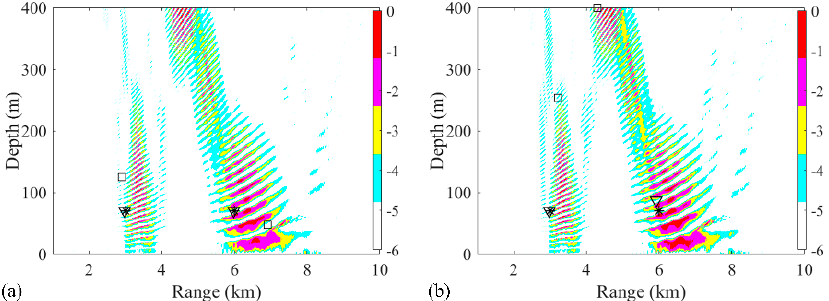
Figure 7. ( a , b ) Ambiguity surfaces generated by different realizations with 14 snapshots using the RAMPMF method, compared to the results shown in Figure 3. True source positions and the positions estimated by the RAMP and RAMPMF methods are represented as black asterisks, squares, and inverted triangles, respectively.